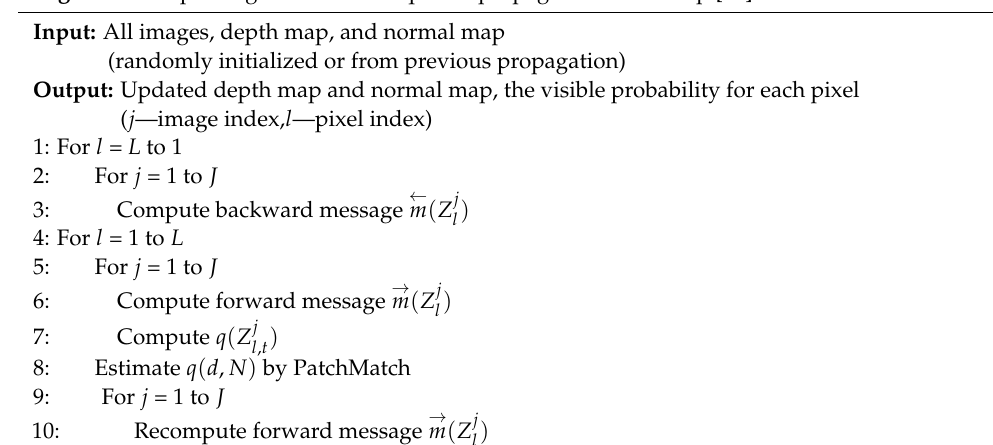
Algorithm 1: Updating schedule of sequence propagation in Colmap [35]